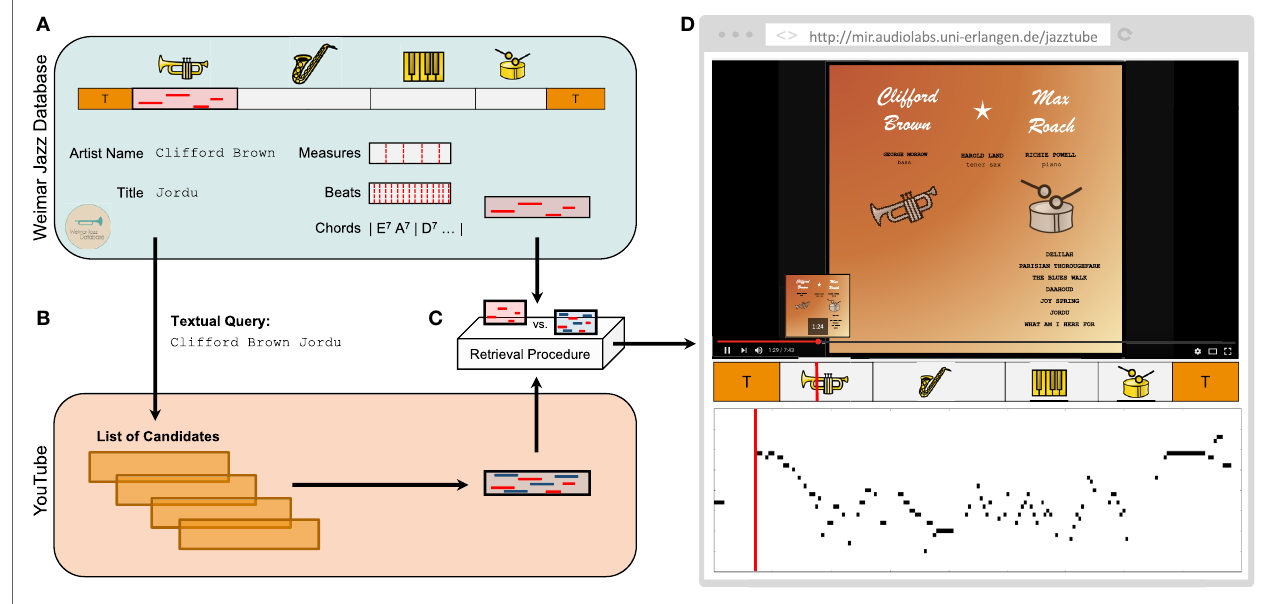
FigUre 1 | Illustration of the two-stage retrieval scenario applied to retrieve videos from YouTube. (a) Overview of the various annotations for Clifford Brown’s solo Jordu contained in the Weimar Jazz Database. (B) First retrieval stage: text-based retrieval on YouTube resulting in a list of candidates. (c) Second retrieval stage: content-based retrieval using the solo recording from the WJD as query. (D) Identified video embedded in a web-based demonstrator and enriched with the annotations obtained from the WJD. Panel (D) has been created by the authors and, therefore, no permission is required for its use in this manuscript.